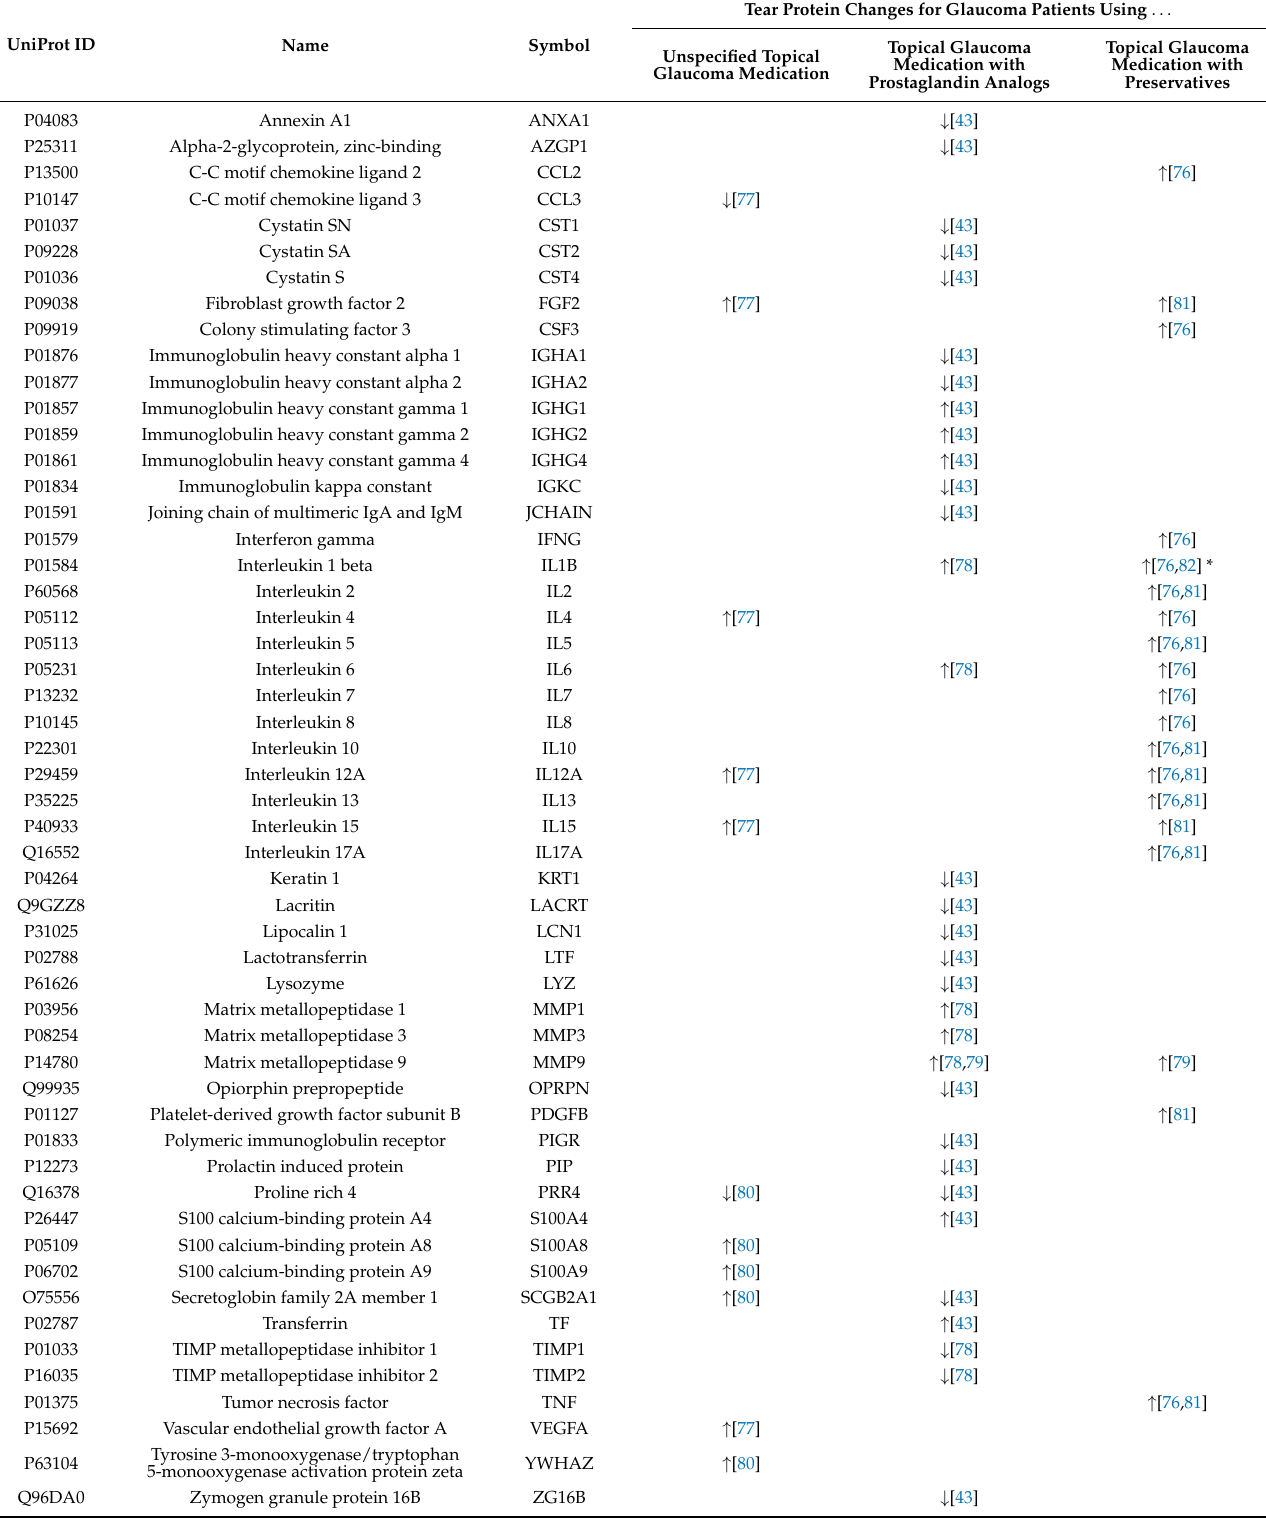
Table 2. The effects of topical glaucoma medication on tear proteins according to previous